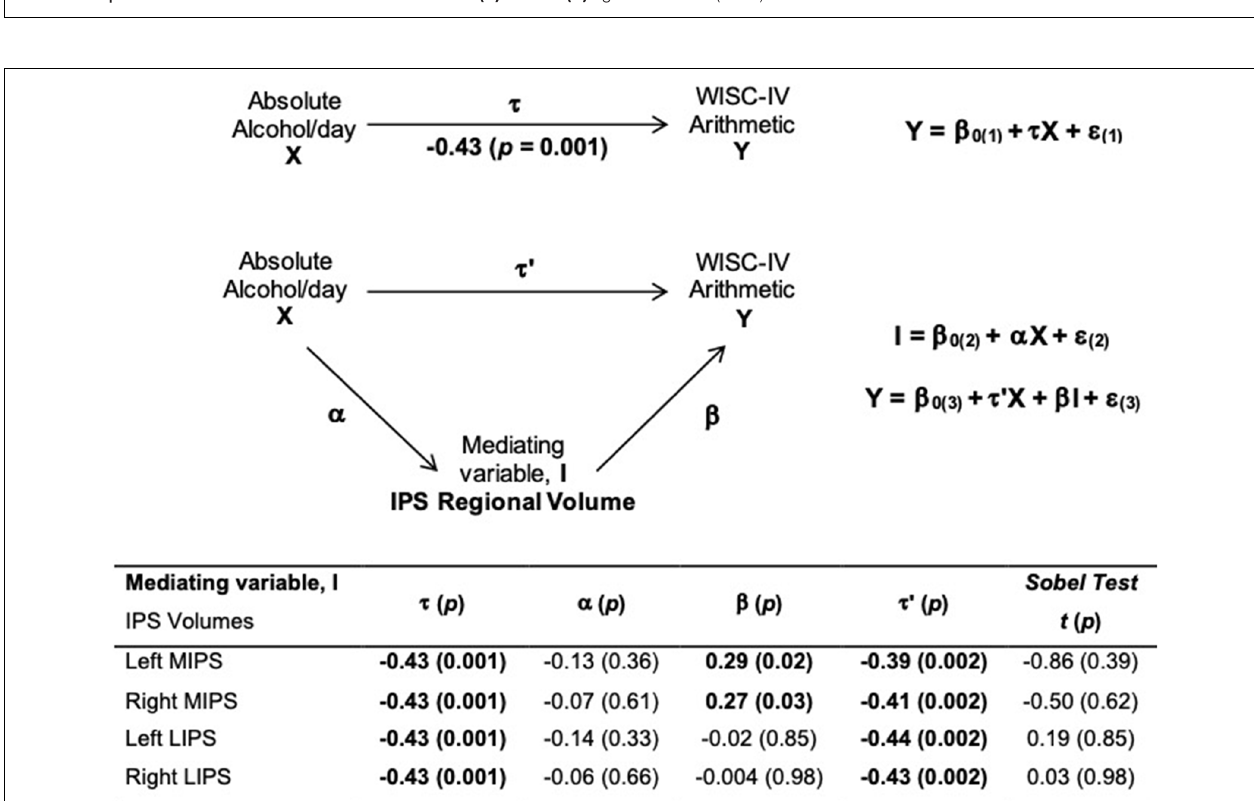
FIGURE 4 | Path model illustrating mediation of the effect of alcohol consumption on WISC-IV Arithmetic by smaller IPS volumes.